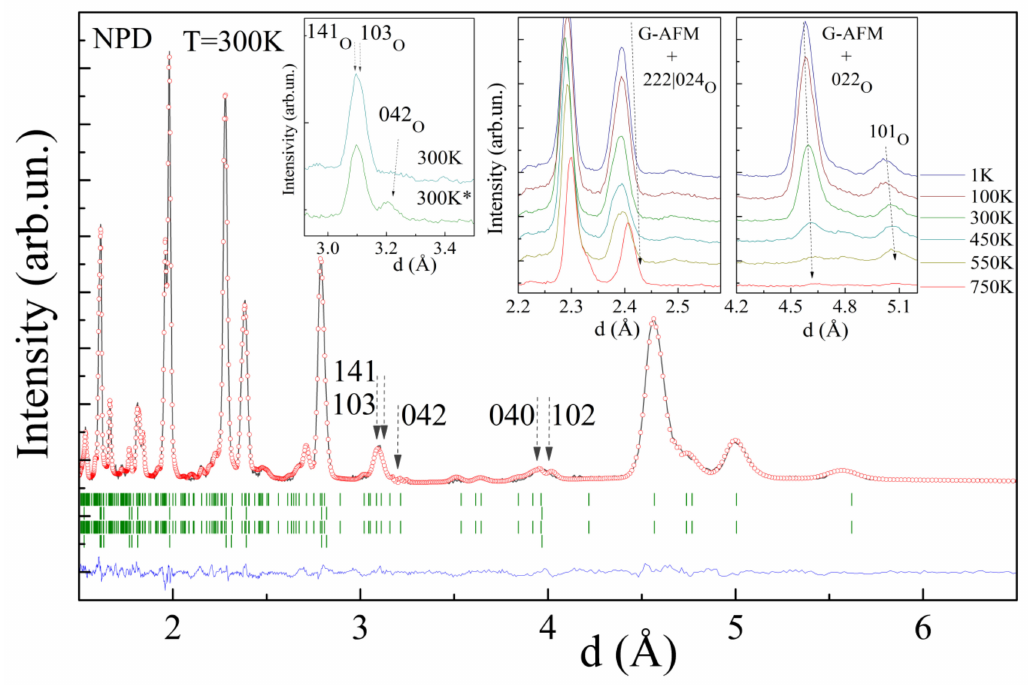
Figure 4. NPD pattern of the compound refined in the two-phase model (upper ticks row denotes the O -phase; second row denotes the R- phase; bottom rows denote related magnetic phases). The insets show the temperature-driven evolution of the specific reflections consisting of the components of both magnetic and nuclear scattering; the pattern marked as 300 K* denotes the data obtained for the annealed